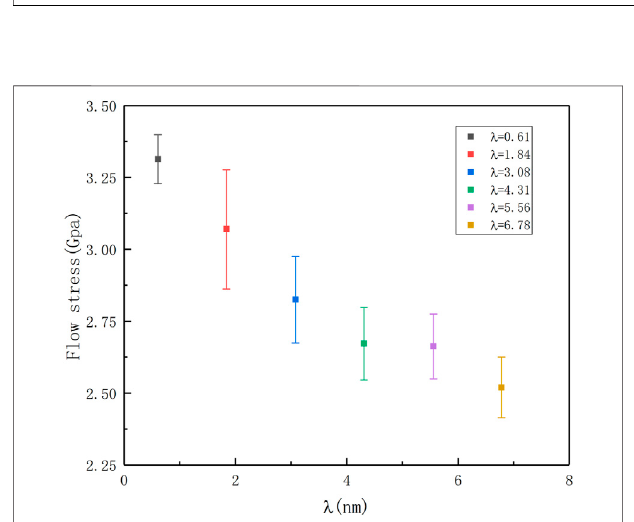
FIGURE5| Average fl owstressdistribution ofthent-HEAs withdifferent twin boundary spacing at 10 – 15% strain range.